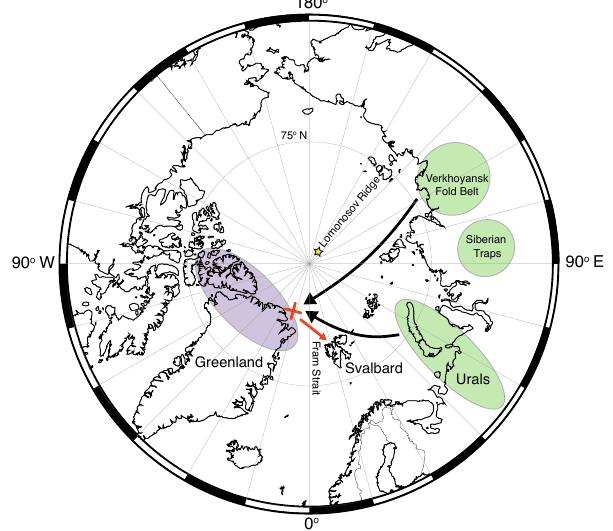
Figure 1. Overview of the circum-Arctic region. The red cross in- dicates the position of Svalbard during the Paleogene (Jones et al., 2016). The purple shaded area indicates the western shield source whilst the green shaded areas indicate potential basaltic source re- gions in the east. The yellow star indicates the location of the Glea- son et al. (2009) study to recover Eocene seawater compositions referred to in the text.